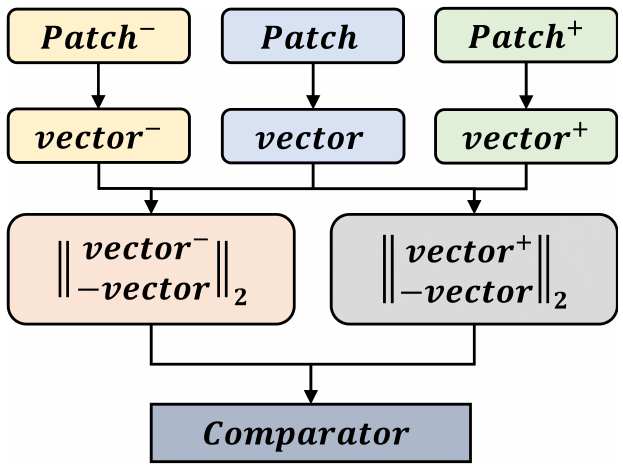
Figure 2. Triplet